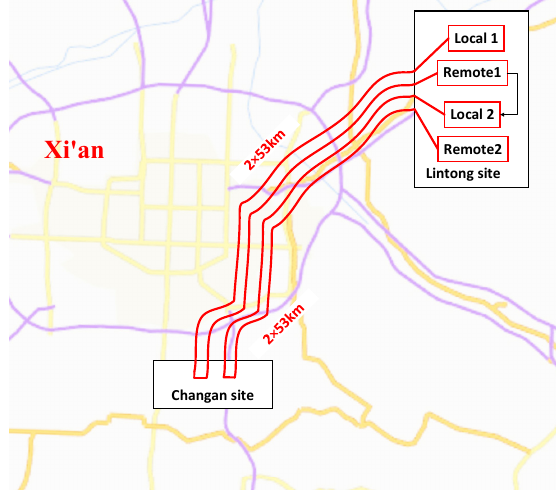
Figure 2. Diagram of the urban fiber links.